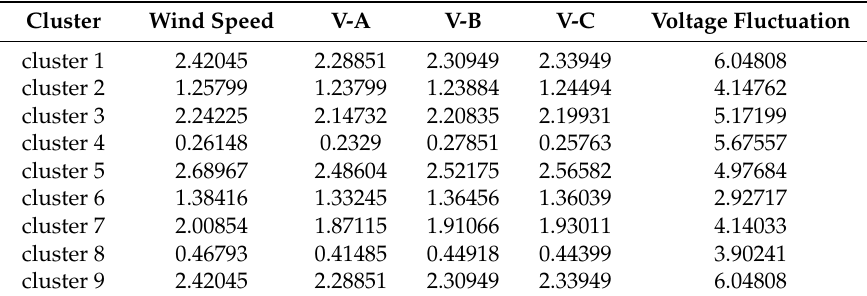
Table 11. Cluster center (k = 8).